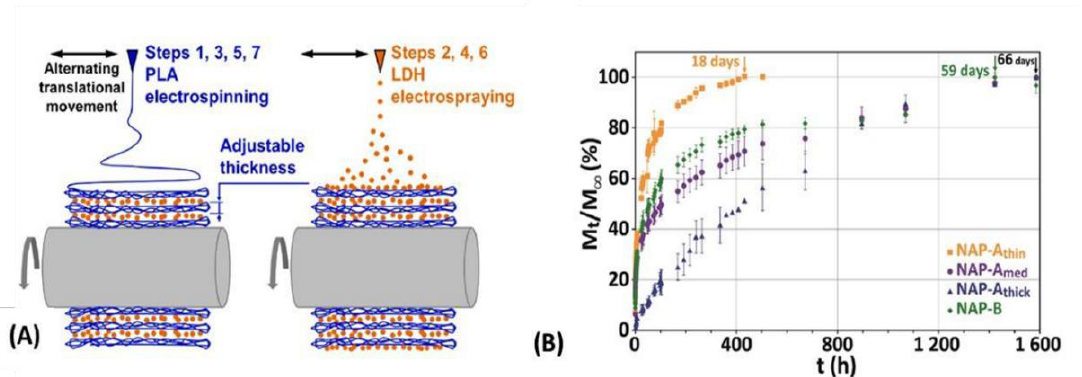
Figure 18. ( A ) Preparation of the composite membranes and ( B ) NAP anions release percentage as a function of time for the different composites (reprinted from Figueiredo et al. [73] with permission of